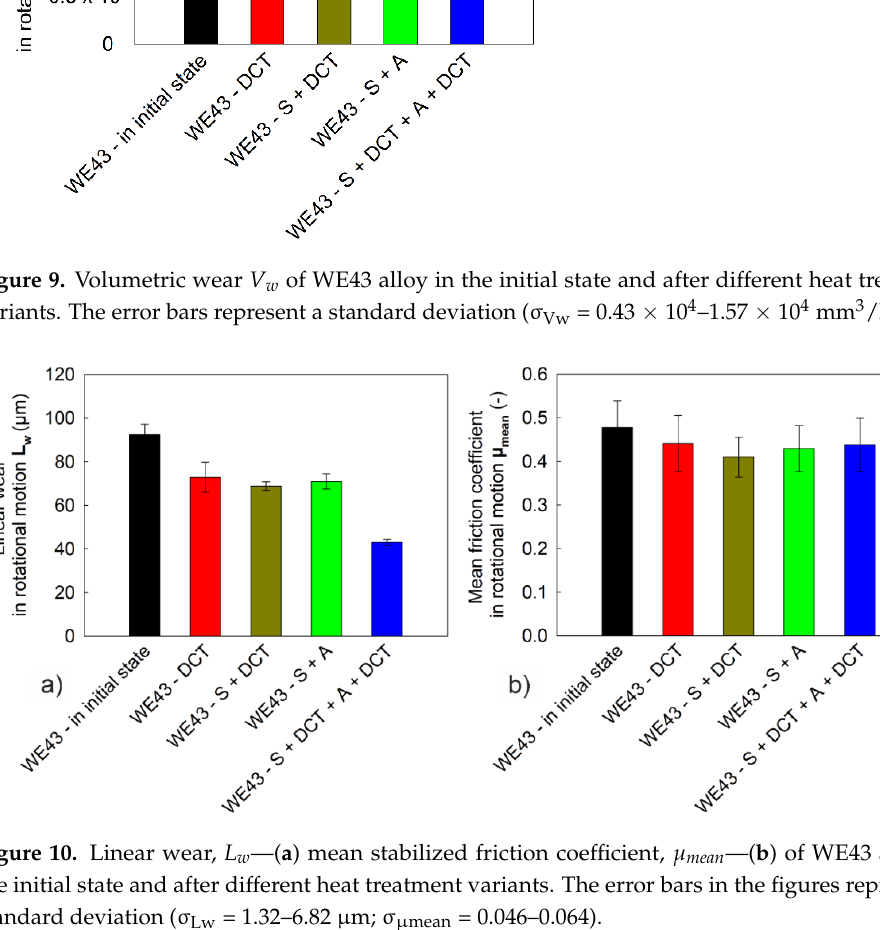
Figure 10. Linear wear, L w —( a ) mean stabilized friction coefficient, µ mean —( b ) of WE43 alloy in the initial state and after different heat treatment variants. The error bars in the figures represent a standard deviation ( σ Lw = 1.32–6. 82 µ m; σ µmean = 0.046–0.064 ) .